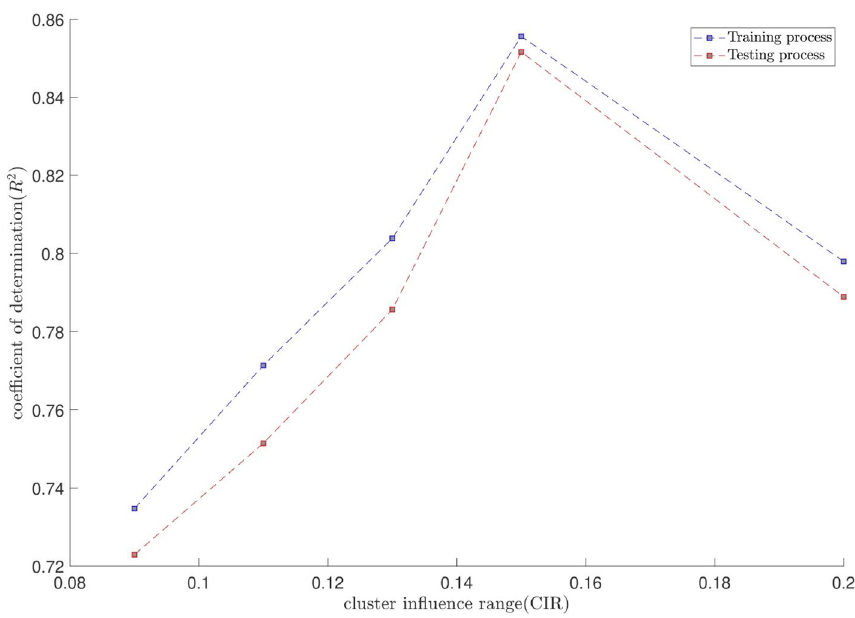
Figure 6. GAFIS method learning processes with changing in cluster influence range